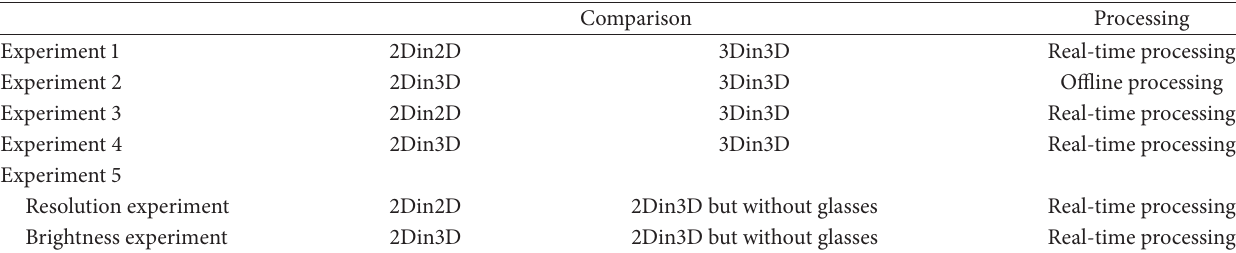
Table 3: Overview of the experiments and their